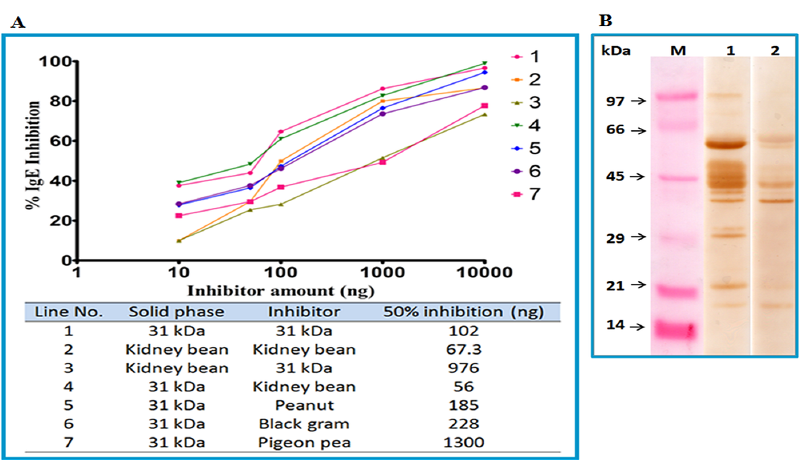
Figure 6. IgE ELISA inhibition of kidney bean extract and 31 kDa protein. Kidney bean protein and extracts of different legumes were used as inhibitor (A). Kidney bean positive patients’ pooled sera (1:10 v/v) was preincubated with 5, 10, 50, 100, 1000, 10000 ng of inhibitor. ELISA was carried out on solid phase coated kidney bean extract (2 m g/100 m l/well) or 31 kDa protein (500 ng/100 m l/well) and preincubated sera. Immunoblot inhibition of kidney bean extract with 31 kDa protein (B). Kidney bean positive pooled patients’ sera was preincubated with 100 m g of 31 kDa protein (lane 2). Immunoblot using kidney bean positive pooled patients’ sera without inhibitor was used as a control (lane 1).